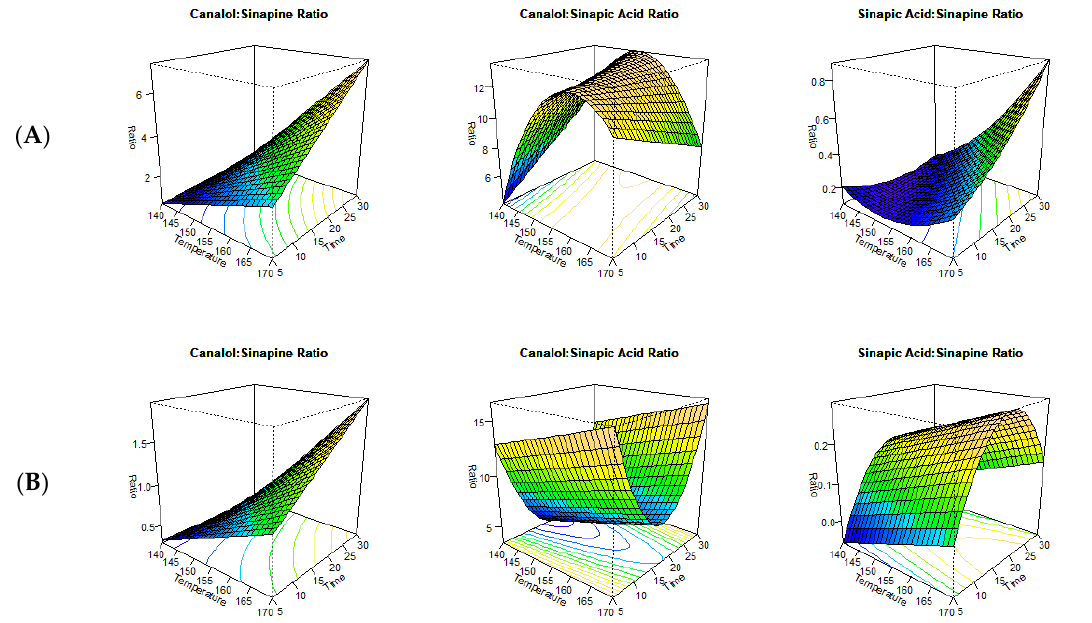
Figure 2. Ratio analysis of the major sinapates (( A )—methanol, ( B )—ethanol).